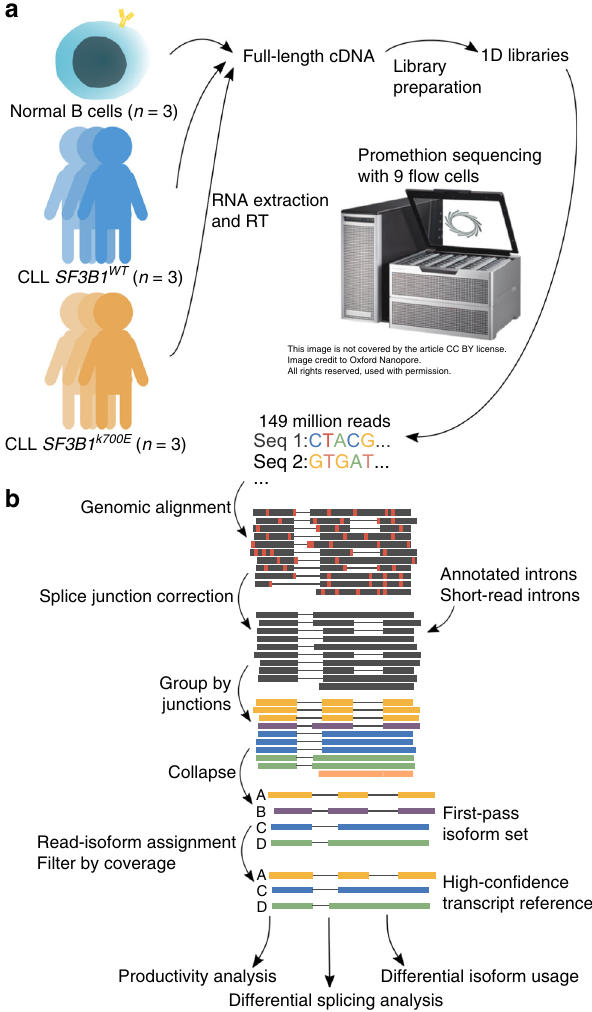
Fig. 1 Long-read nanopore sequencing and FLAIR analysis to identify full- length transcripts associated with SF3B1 mutation in chronic lymphocytic leukemia. a RNA from primary samples across three conditions (chronic lymphocytic leukemia with and without SF3B1 mutation and normal B cells) were obtained. The RNA was prepared into 1D cDNA libraries and each sample was sequenced on a PromethION fl ow cell. The basecalled data were processed using the FLAIR pipeline. b The FLAIR pipeline constructs an isoform set from nanopore reads. First, reads are aligned to the genome with a spliced aligner. The sequence errors are marked in red. Next, they are splice-corrected using splice sites from either annotated introns, introns from short-read data, or both. The corrected reads are grouped by their splice junction chains and are summarized into representative isoforms ( fi rst-pass set). All reads are then reassigned to a fi rst-pass isoform. The isoforms that surpass a supporting read threshold of 3 comprise the fi nal high-con fi dence isoform